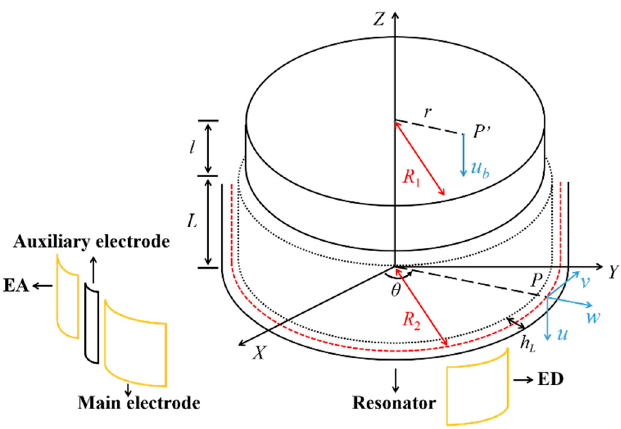
Figure 3. The structure diagram of the resonator with electrodes.